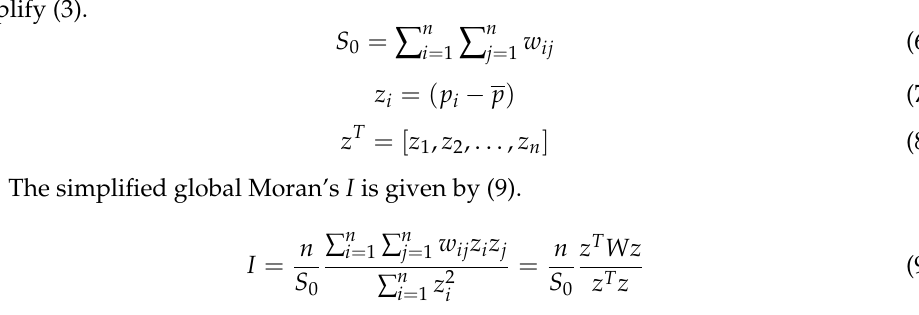
( c ) Figure 1. ( a ) is the satellite image with full channel information, and ( b ) is the synthesized RGB image. ( c ) is cut into nine equally sized blocks based on ( b ).